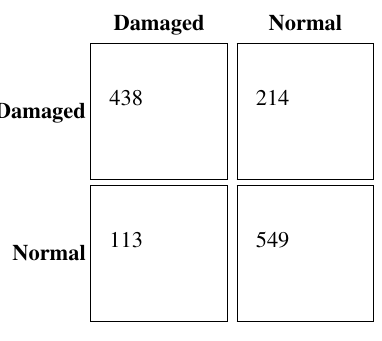
Table 10. Confusion matrix of the Balanced Dataset with data augmentation (rotated images).